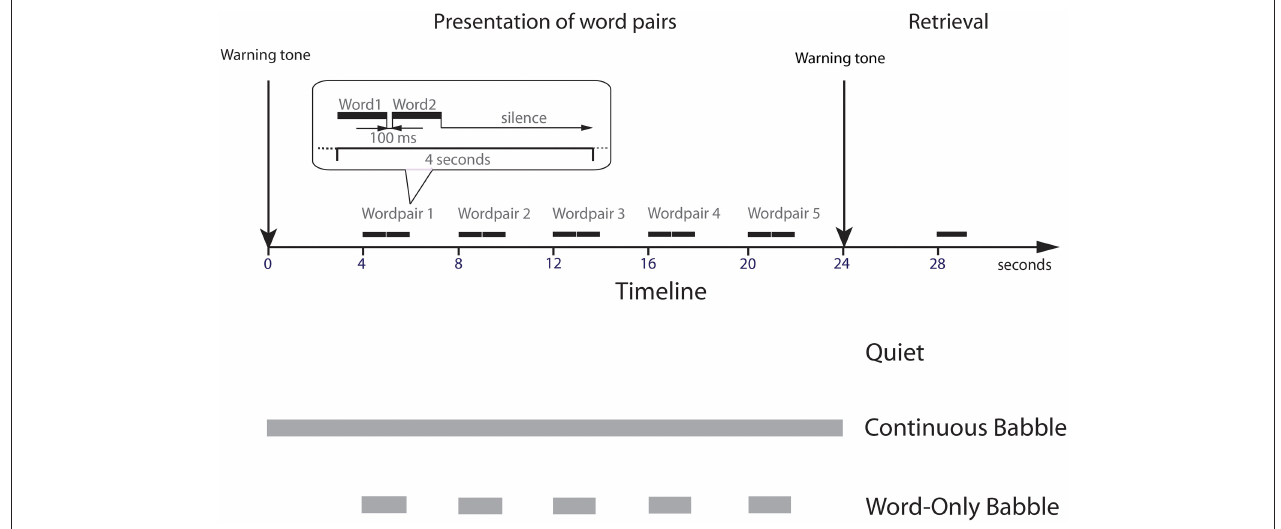
FIGURE 1 | An illustration of the three stimulus conditions tested (Quiet, Continuous Babble and Word-Only Babble). The beginning of a trial was signaled by a warning tone, followed 4s later by the first word pair. Subsequent word pairs were spaced 4s apart with 100ms separating the two words in a pair. A warning tone followed 4s after word pair five. The first word of one of the word pairs was presented in quiet 4s later. In the Continuous Babble condition, the babble was played continuously between the warning tones. For Word-Only Babble, the babble began and ended with the word pair.